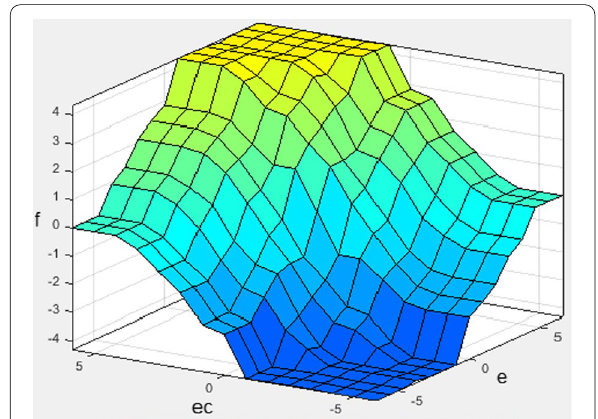
Dynamic tire deflection Dynamic tire force is related to tire deflection. The following equation expresses the RMS of tire deflection—